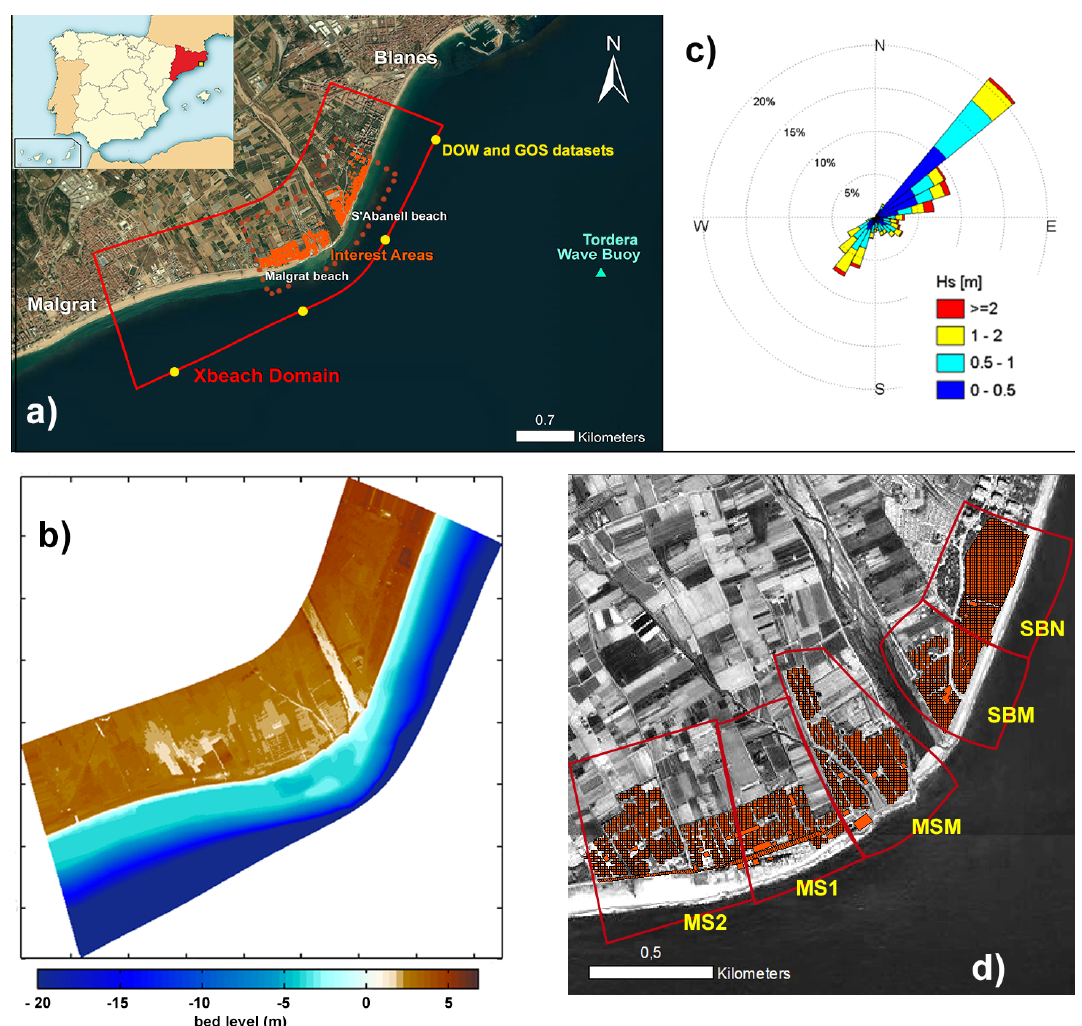
Figure 1. Main locations and characteristics of the study site: (a) location of the Tordera delta, XBeach model domain (red), location of model boundary conditions (yellow, Downscaled Ocean Waves and Global Ocean Surge datasets, Camus et al., 2013), receptors of interest (orange) and Tordera wave buoy (light blue); (b) digital elevation model (DEM) of the Tordera delta; (c) wave rose at the Tordera delta buoy (Global Ocean Waves; Reguero et al., 2012); (d) receptor areas for the local risk assessment. Orthophoto provided by Institud Cartogràgic I Geològic de Catalunay